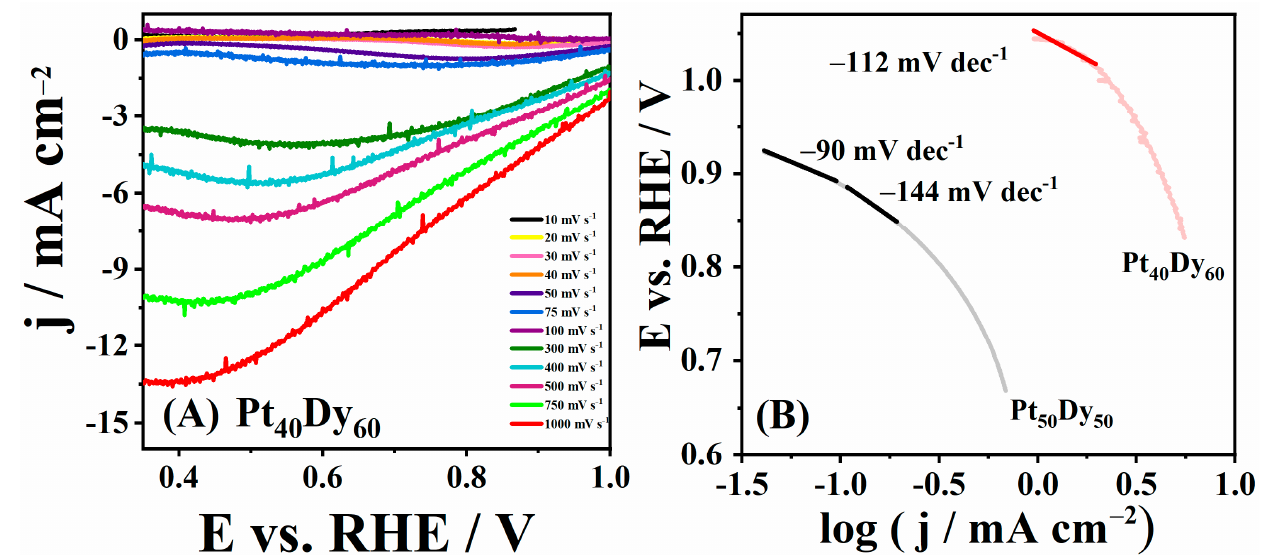
Figure 2. ( A ) Background-corrected LSVs of Pt 40 Dy 60 alloy electrodes at different polarization rates in O 2 -saturated 1 M NaOH at 25 ◦ C with ( B ) Tafel plots of the two Pt–Dy alloy